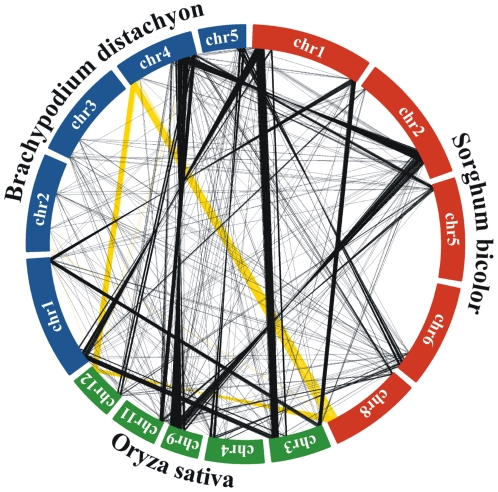
Synteny among Brachypodium, rice and sorghum highlighted by wheat 5A read matches.The genes of Brachypodium, rice and sorghum showing similarities at the amino acid level with the wheat 5A reads obtained in this work were used to link the chromosomes to highlight the syntenic relationships. Yellow lines refer to the reads from short-arm (5AS), while black lines refer to the reads from long-arm (5AL). Only the genes falling on a region with a gene density higher or equal than 50 genes / Mb were considered (see also Figure 4).